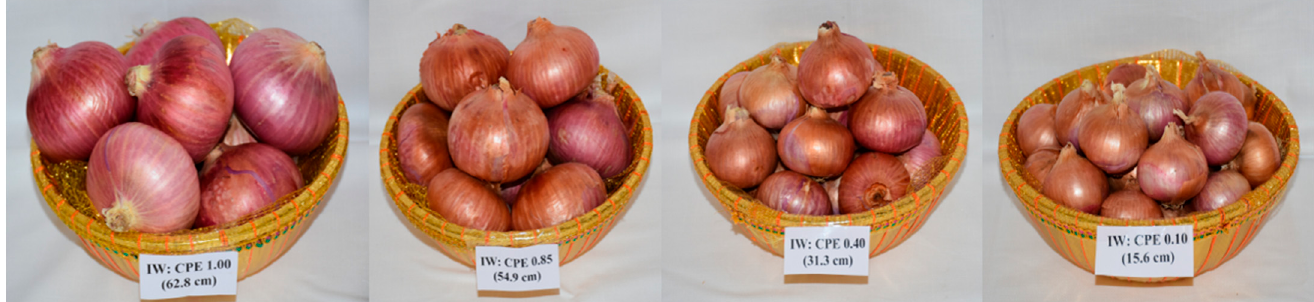
Figure 2. Onion bulbs of cv. Bhima Kiran in different levels of water stress from a left to right (no stress, low, moderate, and severe).